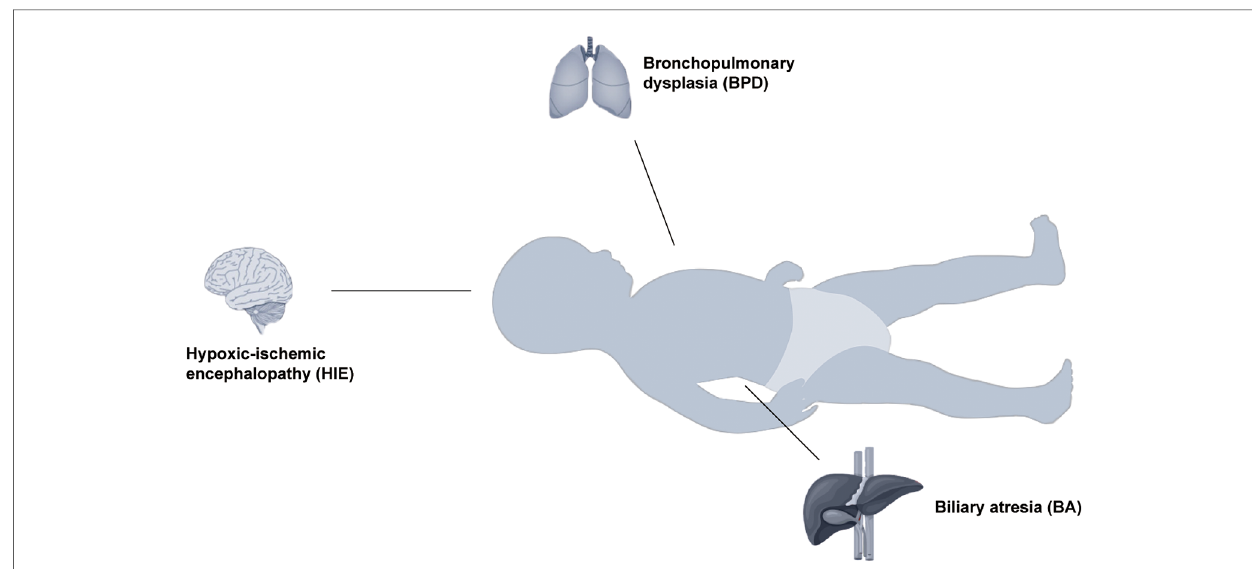
FIGURE 1 Evidence that telomere dysfunction causes some diseases in infants. For newborns, bronchopulmonary dysplasia is mainly associated with the respiratory system, hypoxic-ischemic encephalopathy with the nervous system, and biliary atresia with the digestive